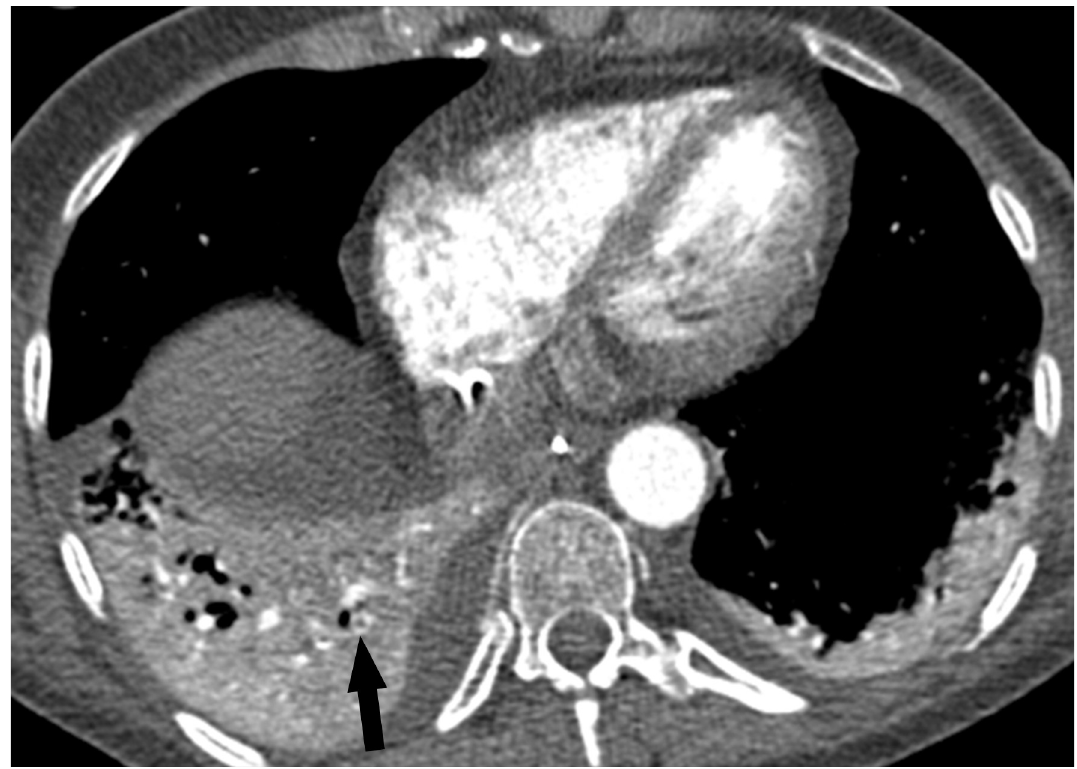
Fig 1. Pulmonary embolism. Axial reconstruction of a CT in soft tissue window showing pulmonary embolism of the right lower lobe.